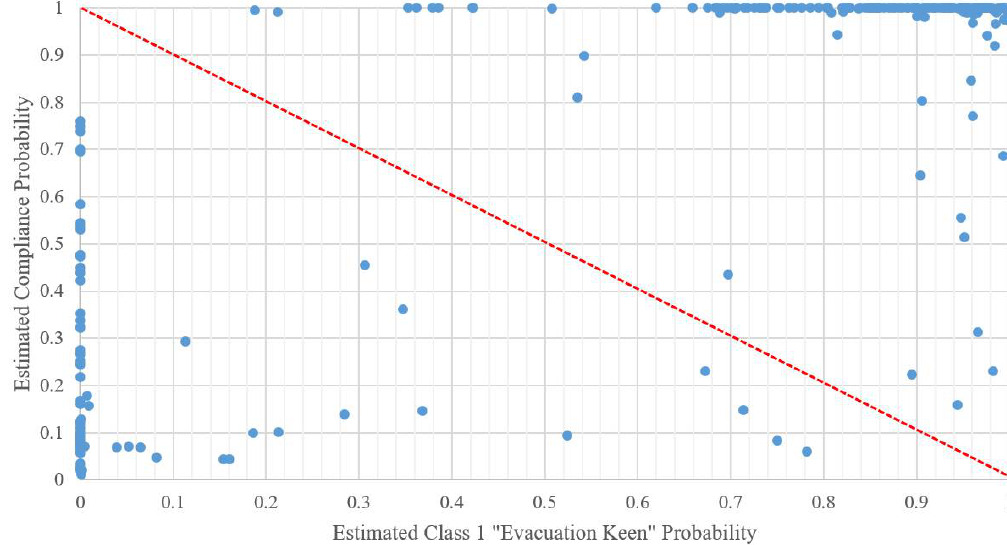
Figure 1. Estimated class-membership probability and compliance probability.